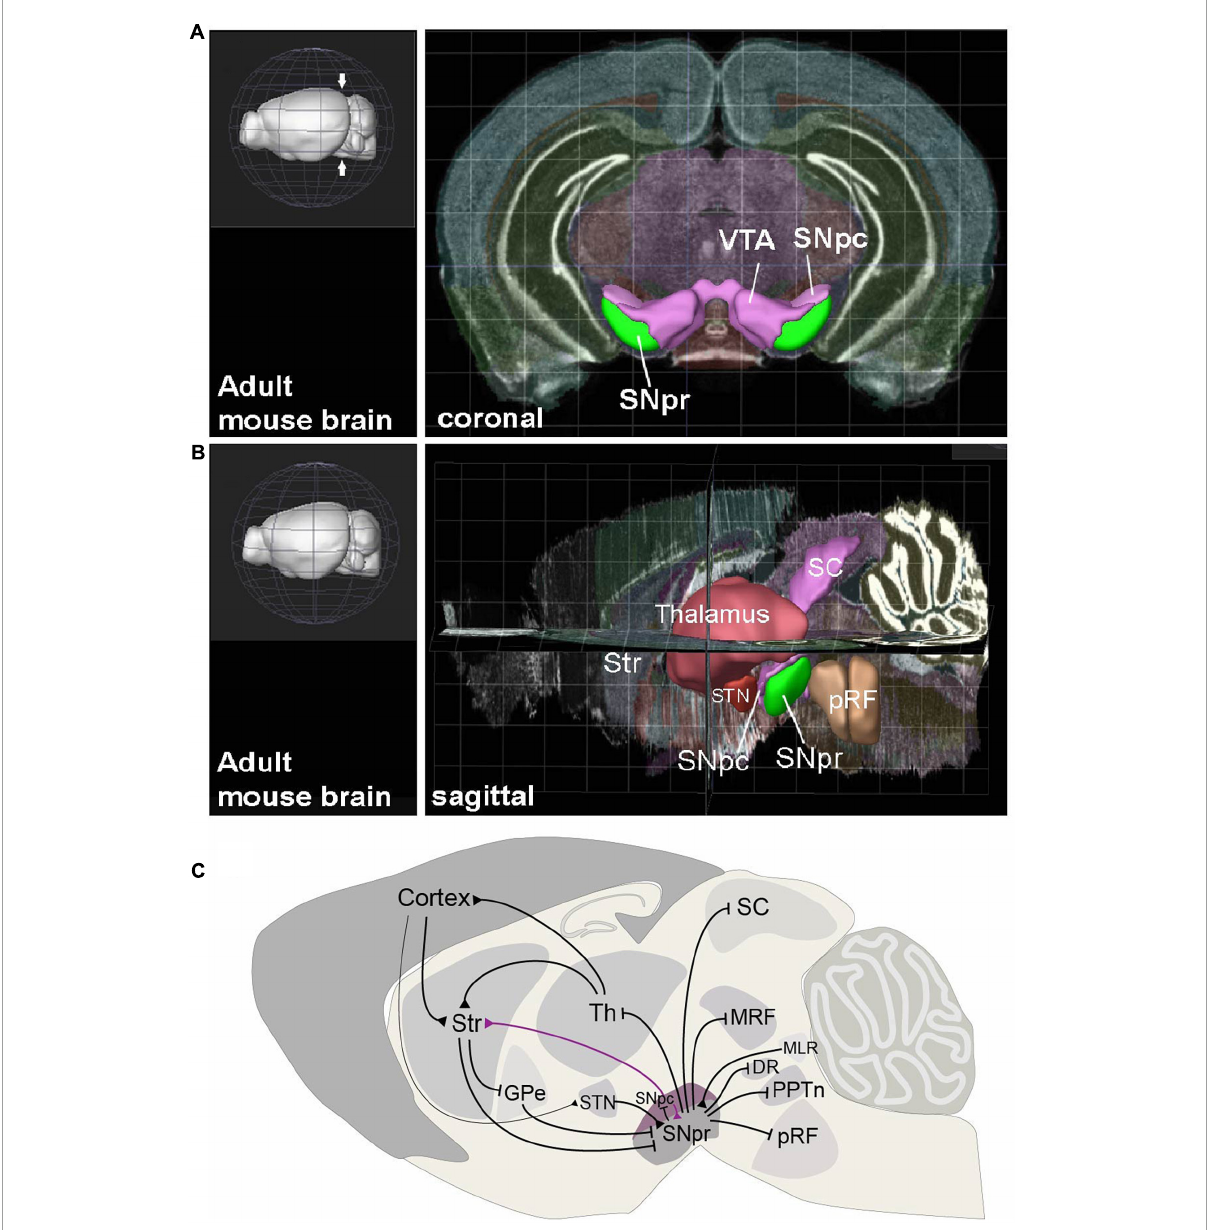
FIGURE1 The anatomical context and connectivity of Substantia Nigra. (A) Coronal view to the adult mouse brain at the level on midbrain (level indicated with arrows on the 3D image in left). The Substantia Nigra pars reticulata (SNpr), pars compacta (SNpc) and Ventral Tegmental Area (VTA) are highlighted. (B) Sagittal view to adult mouse brain, showing the positions of SNpr and its interconnected structures. Str, striatum; STN, Subthalamic nucleus; SC, Superior colliculus; pRF, pontine reticular formation. (C) Input and output structures of the SNpr and their interconnections in mature mouse brain. Black arrows represent inhibitory GABAergic (blunt arrowhead) and excitatory glutamatergic (triangular arrowhead) projections. The dopaminergic neuron projection from SNpc to striatum (Str) is shown in violet. Th, Thalamus; GPe, Globus Pallidus, external segment; MRF, midbrain reticular formation; MLR, midbrain locomotor region; DR, Dorsal Raphe nucleus; PPTn, pedunculopontine tegmental nucleus. The views in (A,B) are created using the Brain Explorer 2 app (Allen Institute for Brain Science,